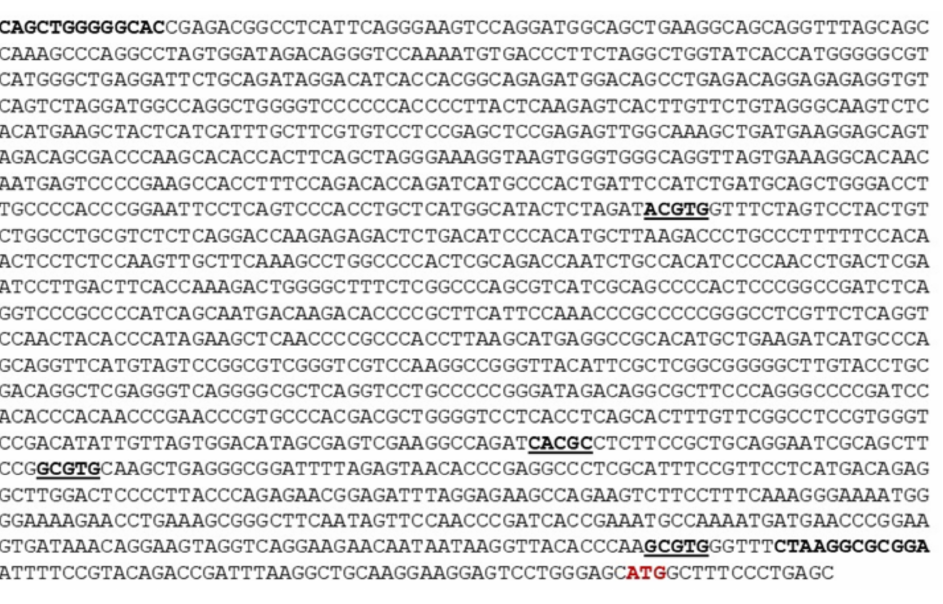
Figure 2. Sequence of the human MORG1 (WDR83) promoter region. The putative HRE binding sites are underlined in bold. The primers used for amplification of the promoter region are shown in bold. The ATG start codon is shown in